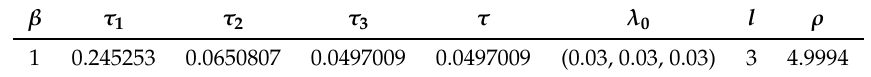
Table 5. Convergence radii for Example 3 with w 0 ( t ) = w ( t ) = et , v ( t ) = e (call them